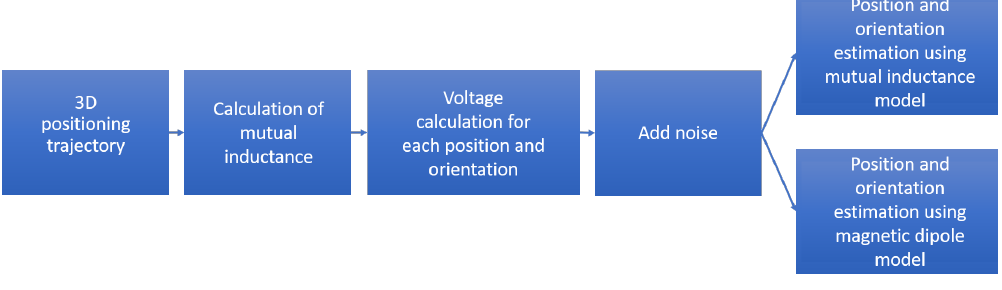
Figure 2. Numerical simulation